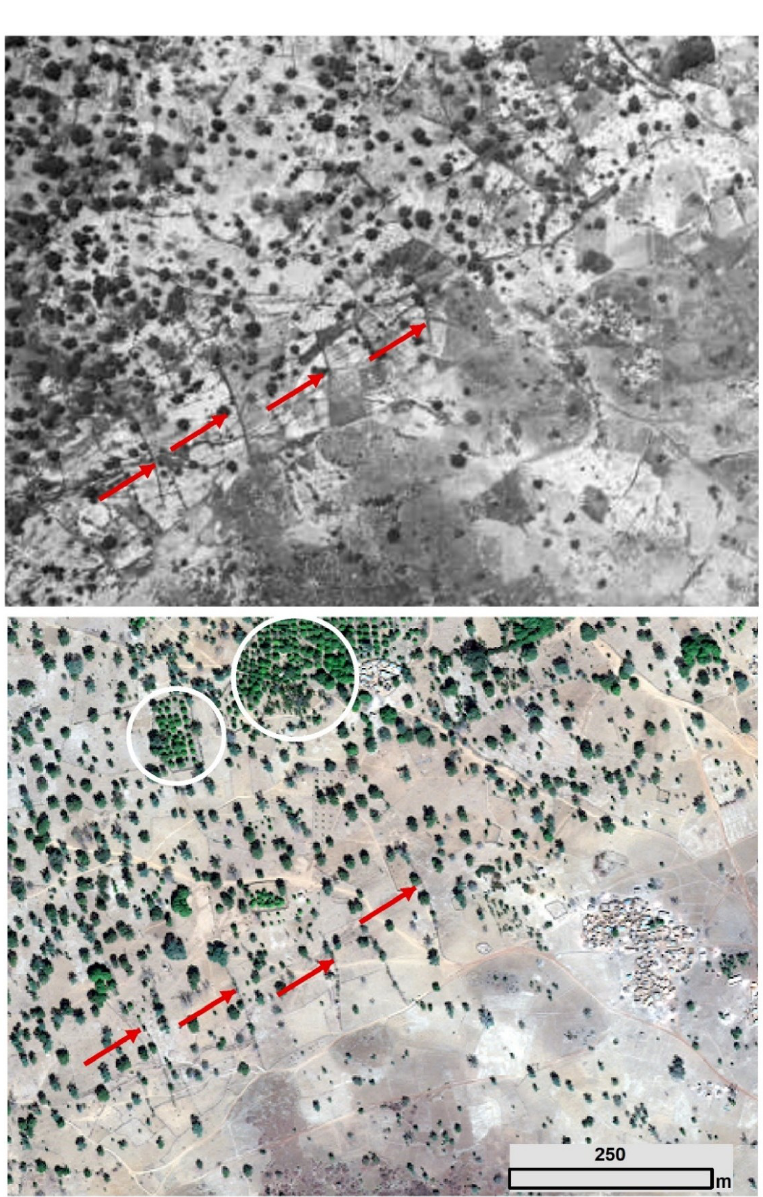
Figure 10. Aerial photo from 1992 (top) and 2013 WorldView-2 image (bottom) for Sakou. Arrows indicate dams.